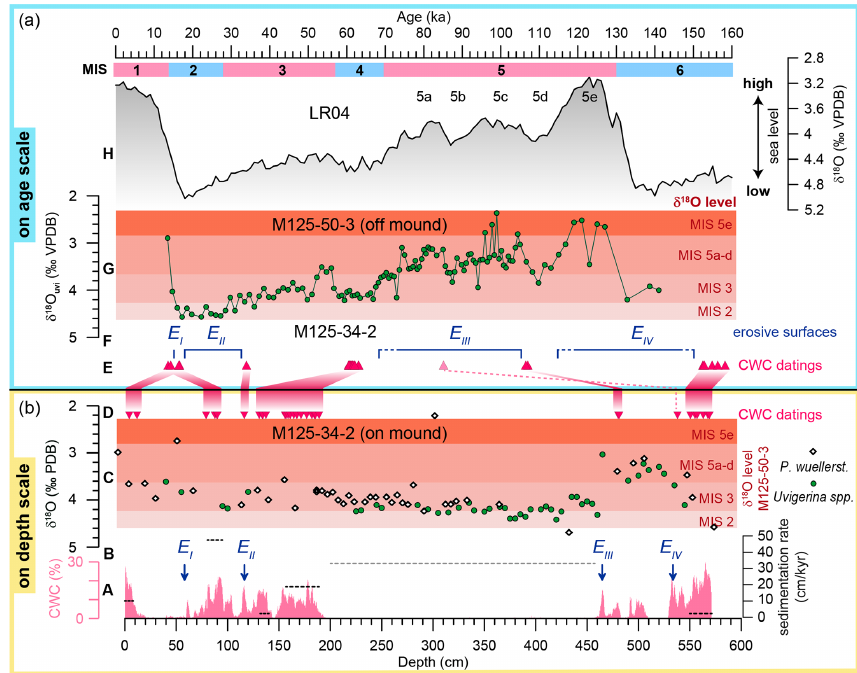
Figure 3. Refined age model of core M125-34-2 from Bowie Mound. Panel (b) displays data from M125-34-2 on depth scale, comprising (A) CWC abundances (%; magenta) based on CT scanning and accumulation rates for both the Th / U-dated CWC-bearing intervals (black dashed lines; cf. Raddatz et al., 2019) and the CWC-barren interval between 200 and 465cm (dashed gray line); (B) blue arrows denote erosive horizons (hiatuses) E I – E IV (cf. Fig. 2); (C) benthic- δ 18 O data from Uvigerina spp. (green dots) and P. wuellerstorfi (white diamonds; elevated by + 0.47 to adjust for the interspecies offset to Uvigerina spp. after Marchitto et al., 2014); red horizontal shadings indicate reference δ 18 O levels for the respective marine isotope stages (MISs) taken from off-mound core M125-50-3 (see G ); (D) red triangles mark Th / U datings. Panel (a) displays data in the time domain with (E) Th / U dates of M125-34-2; (F) the inferred duration of hiatuses reflected by erosive horizons E I – E IV of core M125-34-2; (G) the δ 18 O record on Uvigerina spp. in off-mound core M125-50-3, with red horizontal shadings illustrating the δ 18 O level during different isotope stages as used in (C) ; and (H) the LR04 benthic stack (Lisiecki and Raymo, 2005) as an approximation for eustatic sea-level changes. MISs are indicated by pink and blue bars, signifying relatively warm and cold periods,